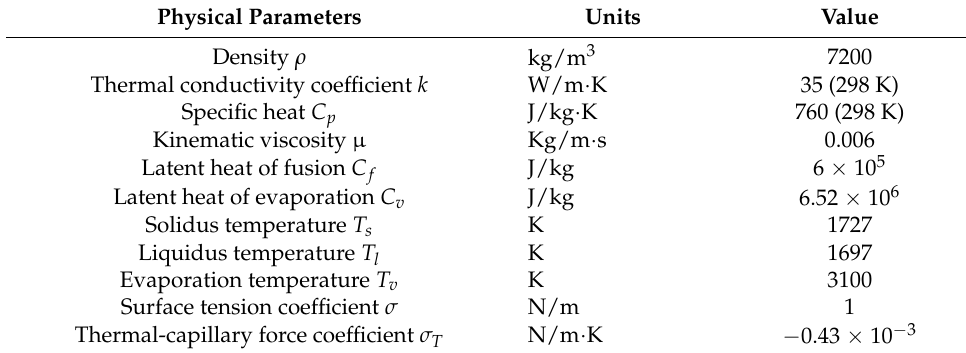
Table A1. Physical parameters in the LSMW simulation